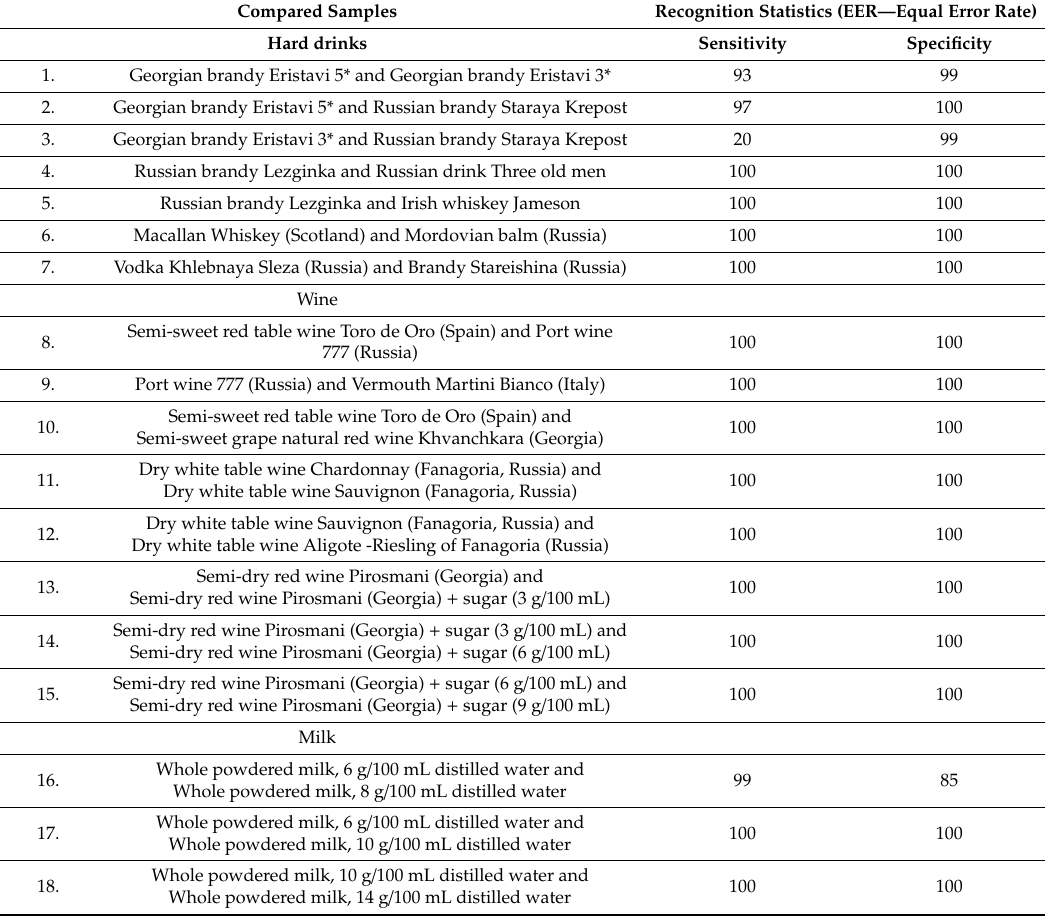
Figure 7. Software interface ( a , b ). A variety of shapes of hodographs of liquids of di ff erent classes: Figure 7 . Software interface (a,b). A variety of shapes of hodographs of liquids of different classes: 1 - 1—dry red wine; 2—cognac; 3—whiskey; 4—balm; and 5—vodka. dry red wine; 2 - cognac; 3 - whiskey; 4 - balm; 5 - vodka. The recognition statistics, Sensitivity and Specificity, based on the calculation of the hodographs DI of the compared samples and errors of the first and second kind are presented in Table 2. Table 2. The obtained di ff erences between the compared